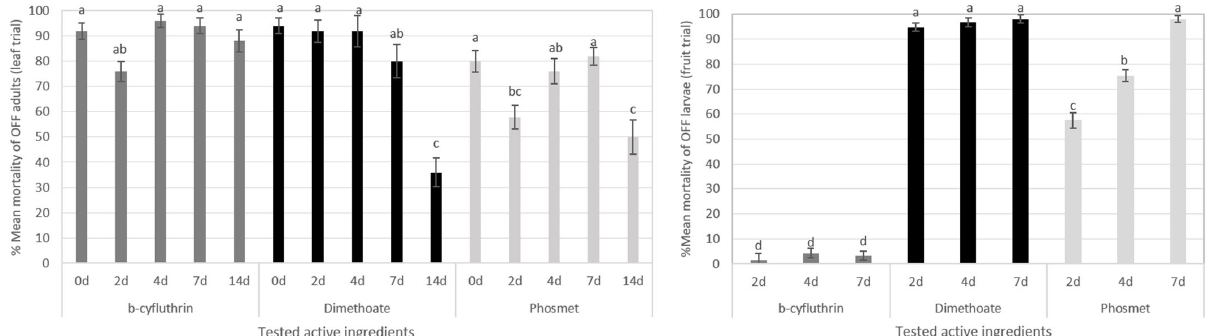
Figure 8. Mean ± SE recorded mortality of olive fruit fly adults ( left ) and larval stages ( right ) for each tested insecticide and observation day. Records of mortality with the same letter are not significantly different at p <